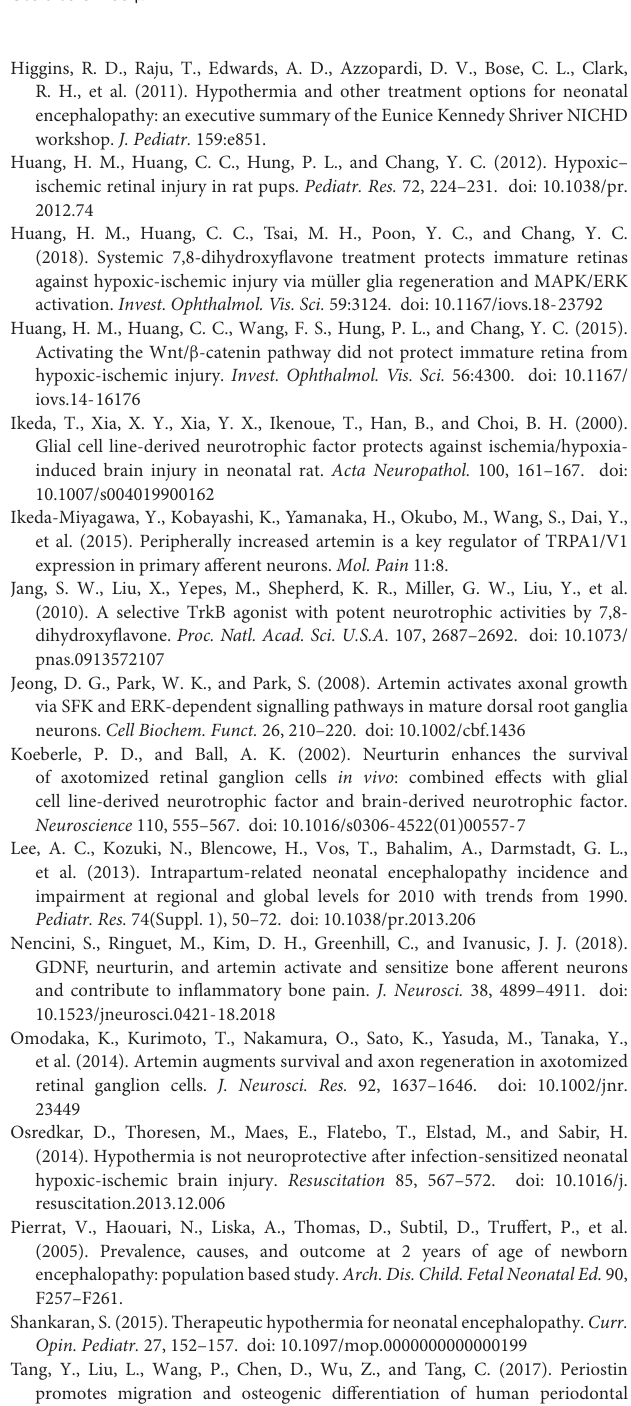
Supplementary Figure 4 | Intravitreal injection of ARTN does not increase cell proliferation but decreases neuroinflammation and astrogliosis. Nuclear counterstaining with DAPI (blue) showed (A) most of the Brdu + cells (red) are localized in the RGC and INL at P17; (B) the GFAP immunostaining (green) was